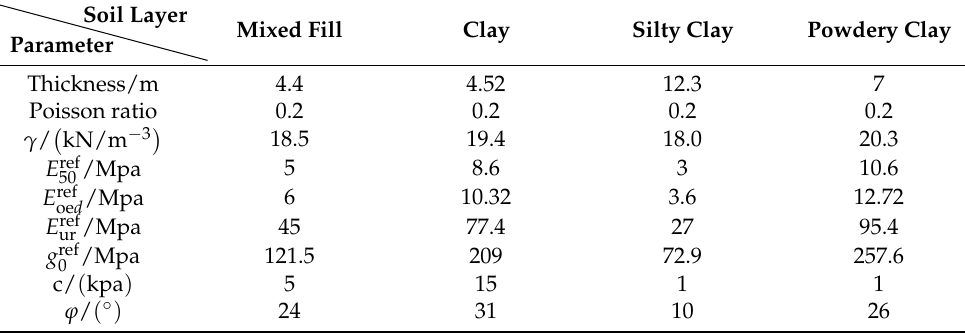
Table 1. Structural properties adopted in the numerical